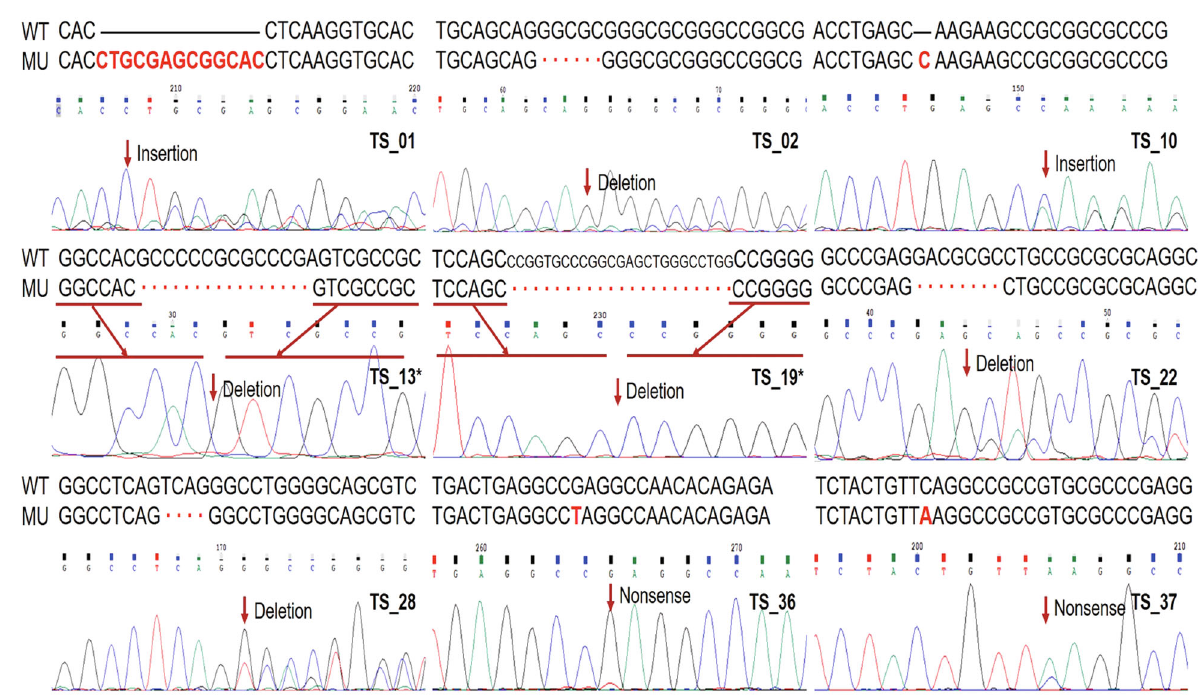
Fig. 4 Somatic ZFPM1 mutations were con fi rmed in nine EPCs by Sanger sequencing. Top: DNA sequences for wild-type and mutated alleles. Below: Sanger sequencing validation electrophoretograms. WT, wild-type allele; MU mutated allele. * A further explanation for TS_13&19 in Supplementary Fig. 4.